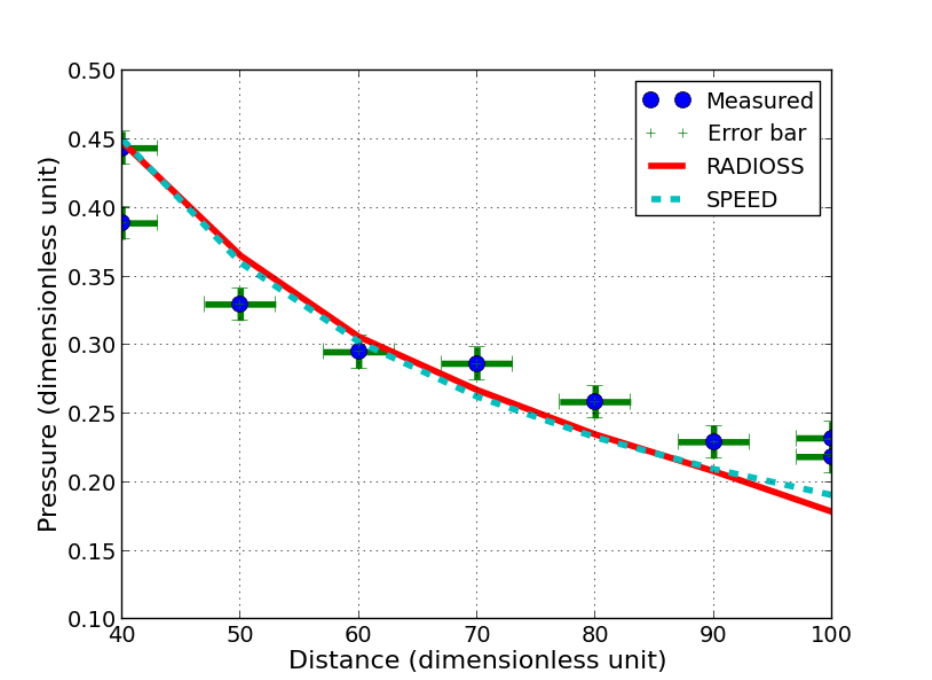
Figure 17. Comparison of incident pressure versus distance between experiments and simulation with RADIOSS ® (0.25 mm square elements) and SPEED ® (0.05 mm square elements) using dimen- sionless units. Experimental pressure is converted to incident pressure using 1D shock theory as explained in Section